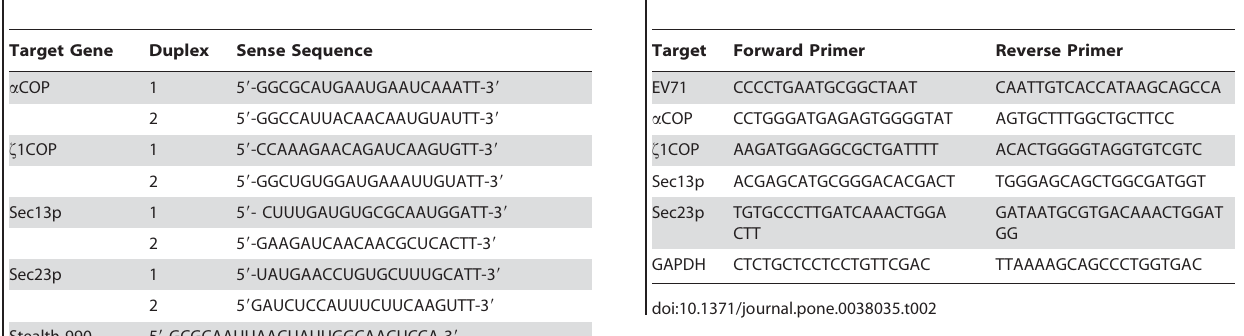
Table 1. siRNA sequences used in this study. Table 2. Quantitative real-time PCR